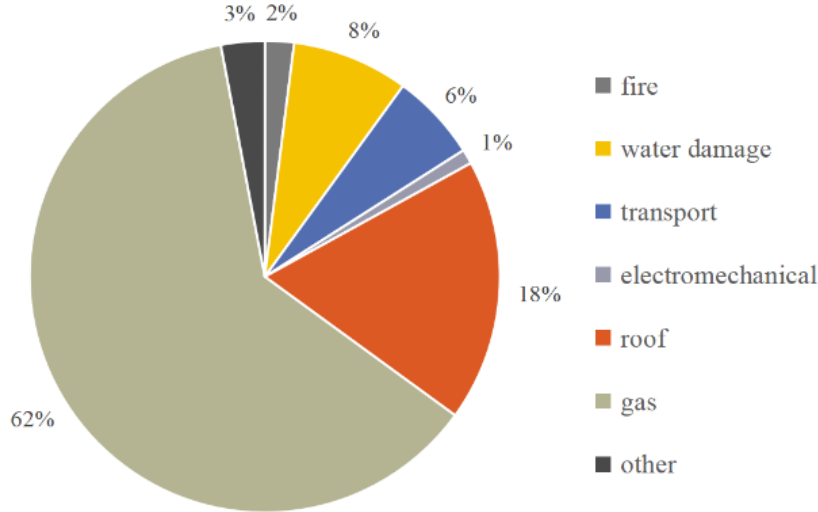
Figure 1. The number of deaths in various large accidents in coal mines.